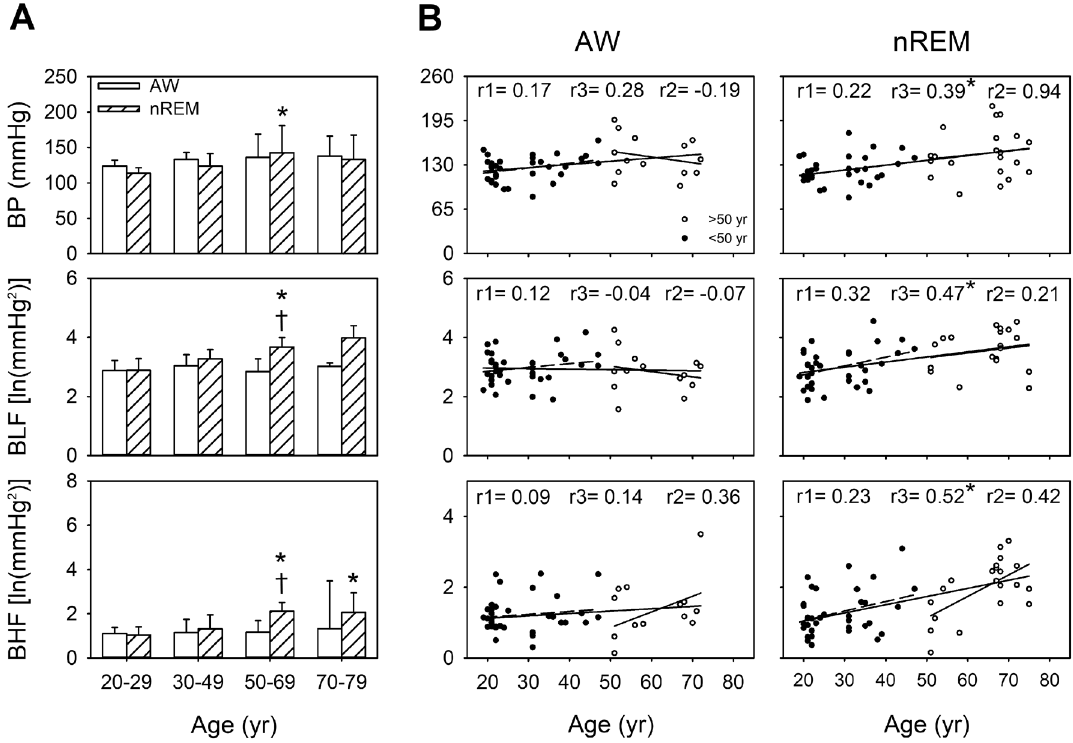
Figure 1. Blood pressure (BP)/arterial pressure variability (APV) parameters during wakefulness (AW) and non-rapid eye movement sleep (nREM) in the different age groups, and the comparisons of BP/APV between the AW and nREM for the different age groups in all participants ( A ). * p < 0.05 vs. 20–29. † p < 0.05 vs. the awake stage. The values are presented as means ± SEMs. Two-dimensional scattergrams for the BP/APV–age relationship during AW and nREM in all participants ( B ). * p < 0.05. r1: correlation coefficient in the 20–49-year age group. r2: correlation coefficient of 50–79-year age group. r3: correlation coefficient of 20–79-year age group. Abbreviations: ln, natural logarithm; BLF, LF of arterial pressure